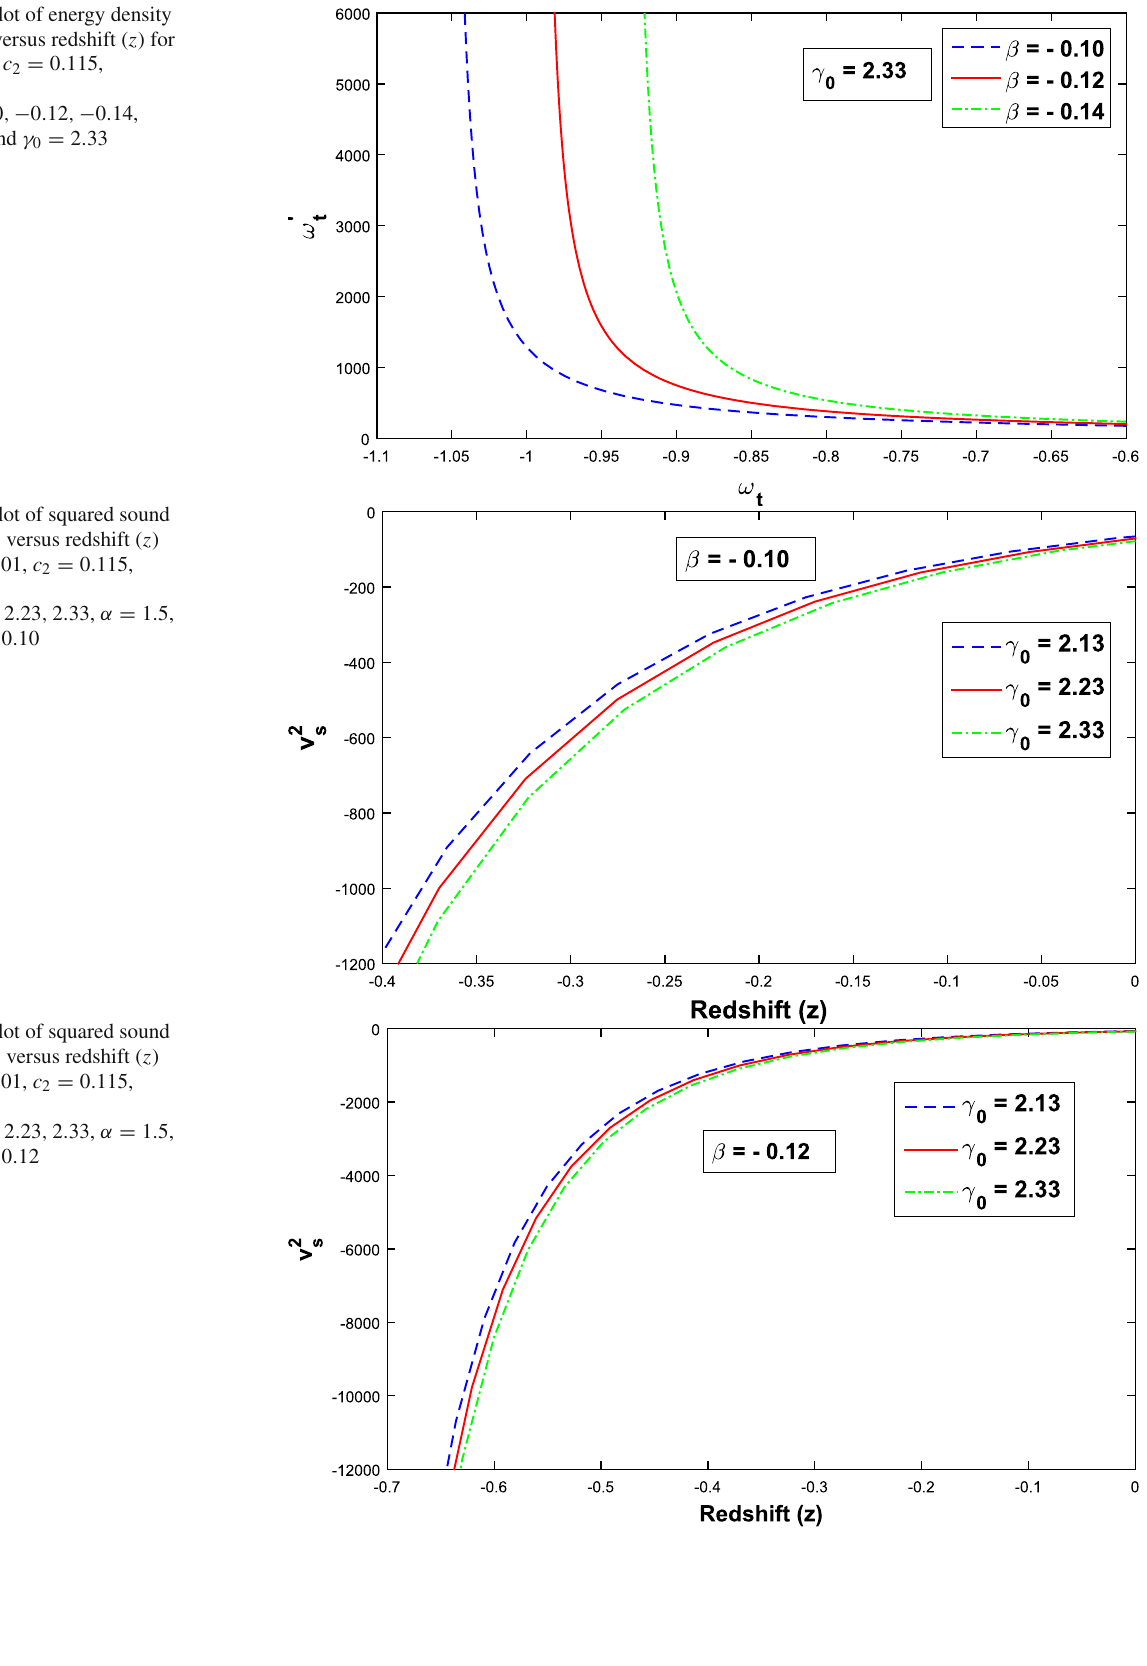
Fig. 13 Plot of squared sound speed ( v 2 s ) versus redshift ( z ) for c 1 = 0 . 01, c 2 = 0 . 115, k = 0 . 325, γ = 2 . 13 , 2 . 23 , 2 . 33, α = 1 . 5, 0 and β = − 0 . 10